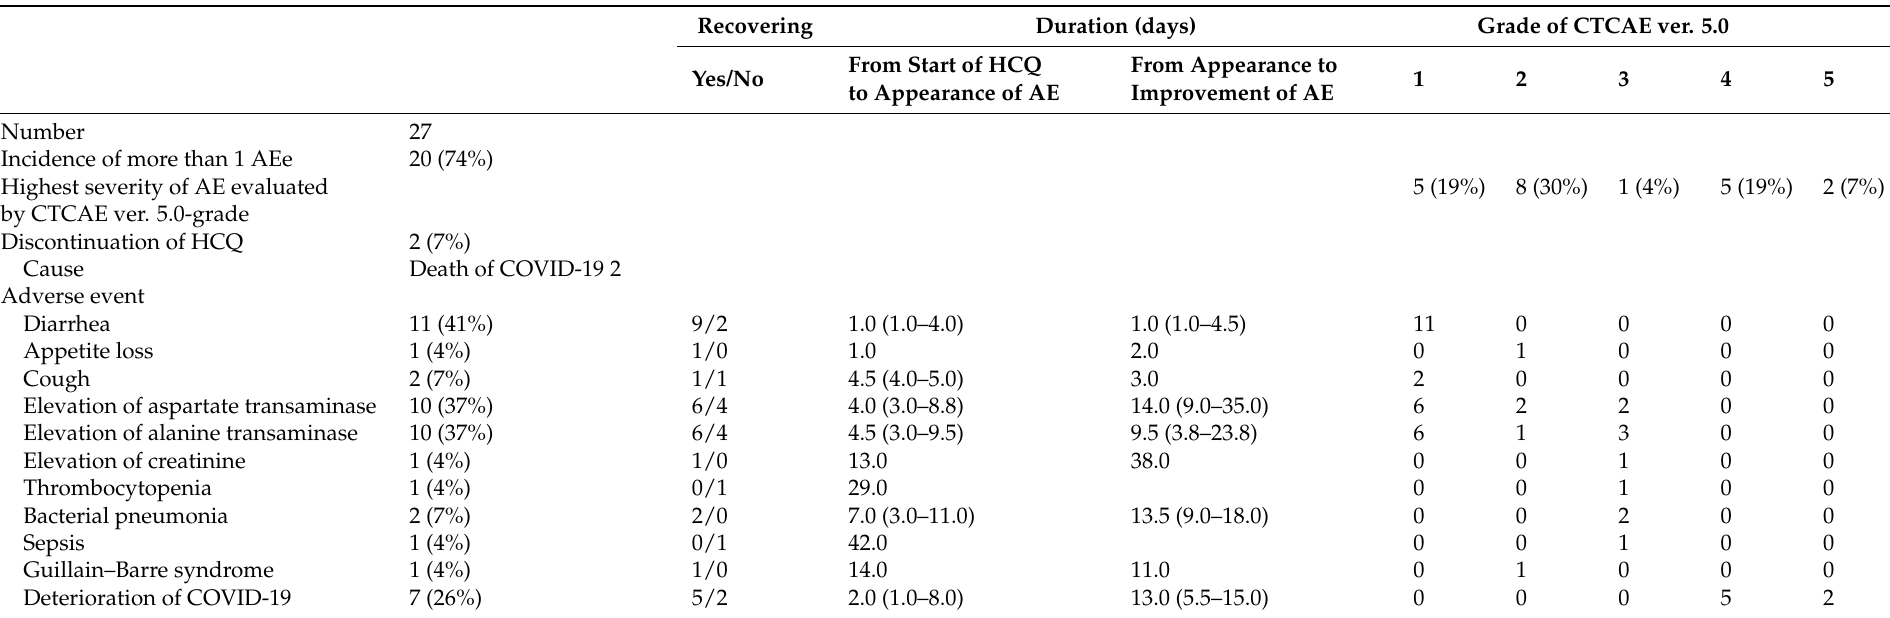
Table 3. Adverse events experienced by